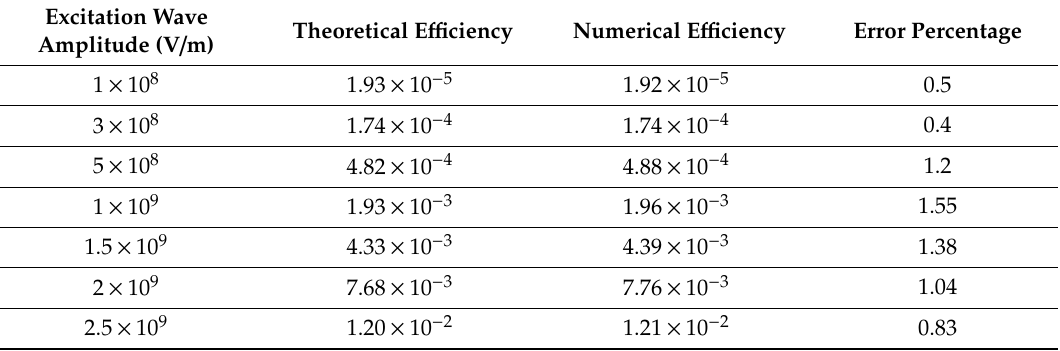
Table 3. Comparison of the numerical and experimental results for di ff erent excitation amplitudes